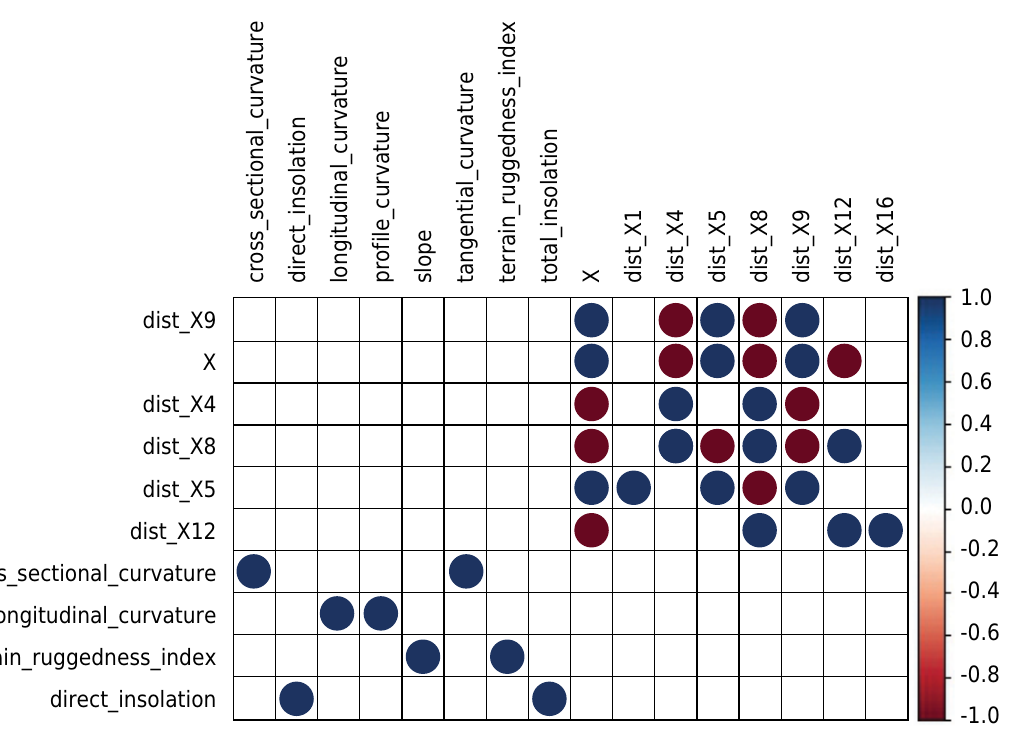
Figure 4. The high correlation covariates, considering all covariates. The Y-axis shows the eliminated